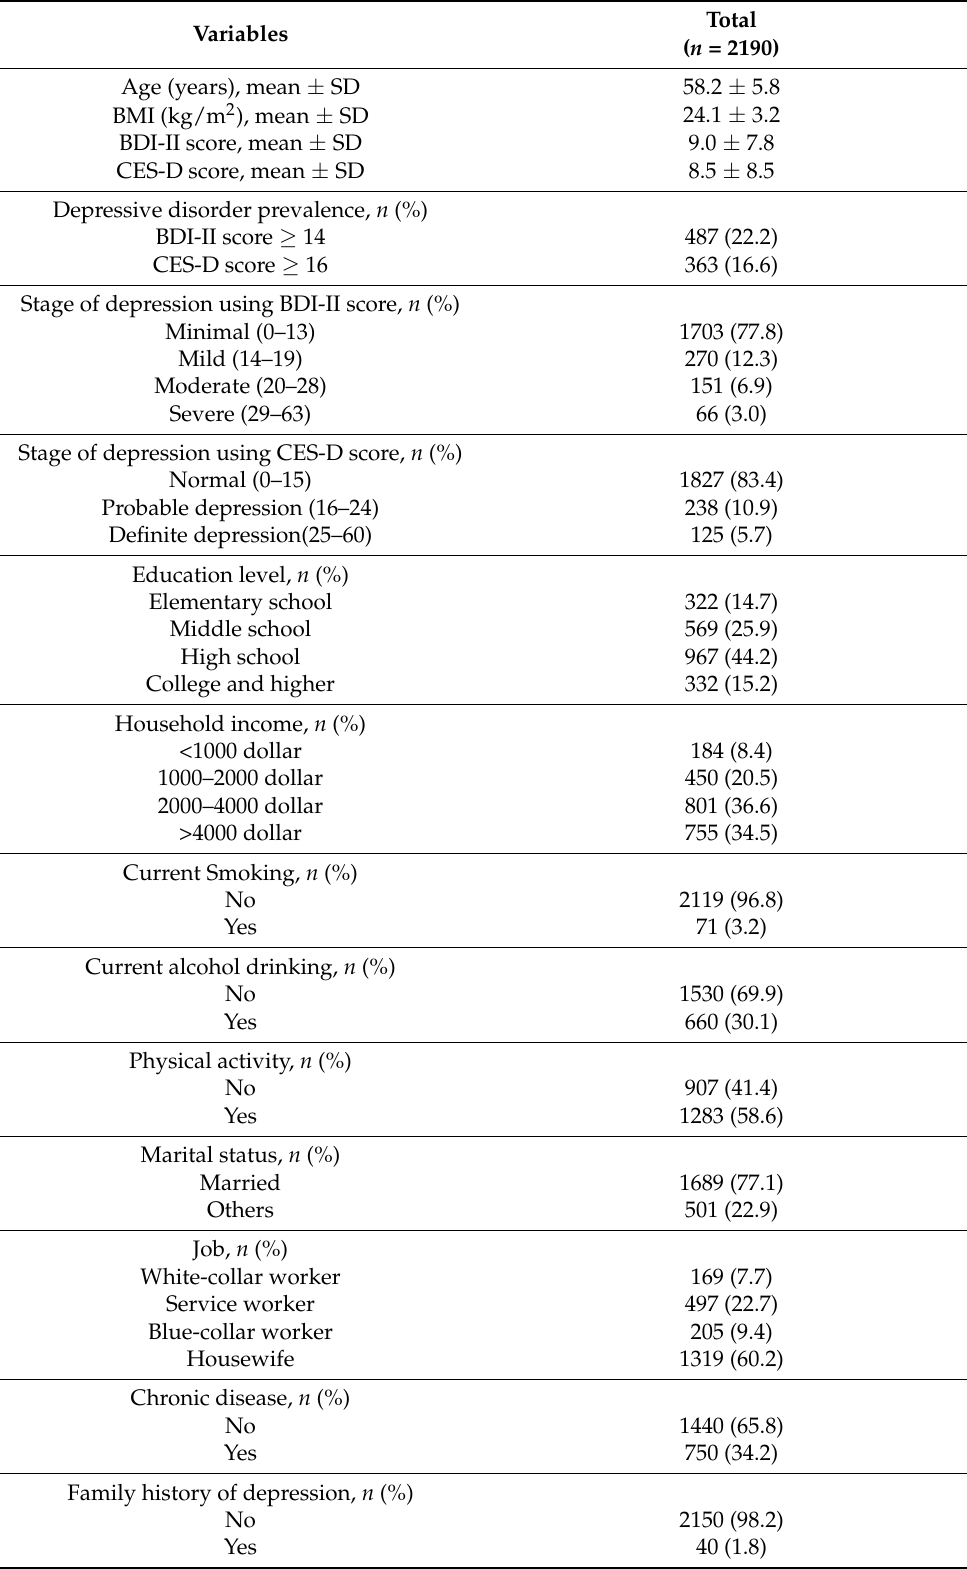
Table 1. Characteristics of the